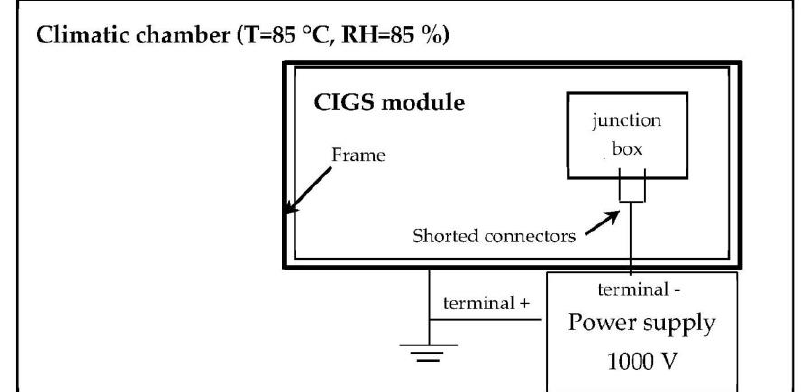
Figure 5. PID setup with grounded frame, the PV connectors are shorted and connected to the negative potential of the power supply.